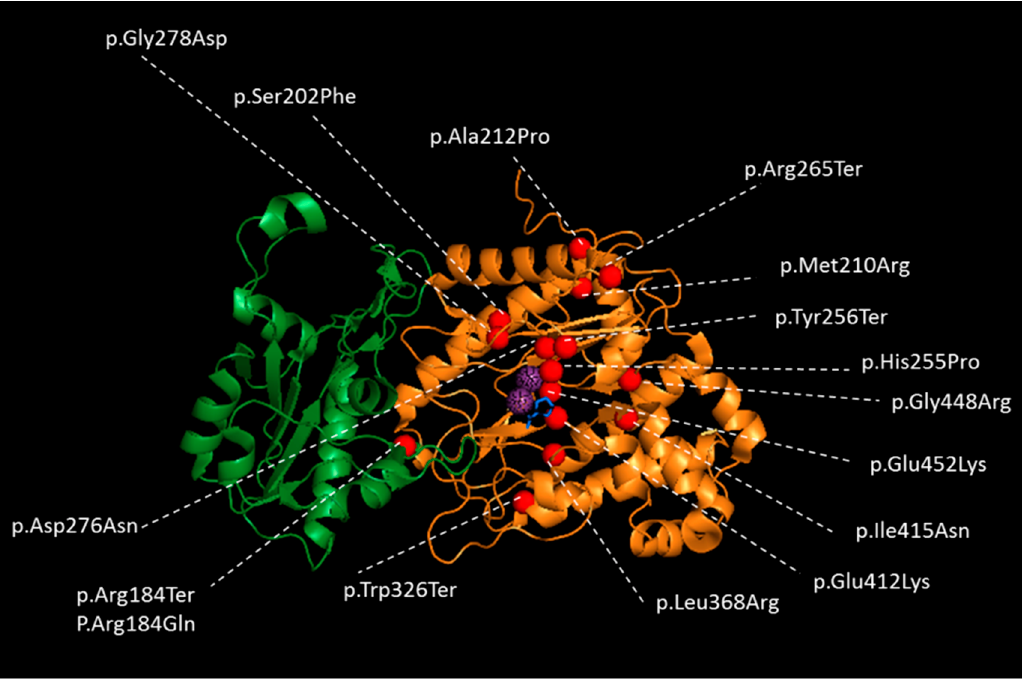
Figure 2. Crystal Structure of one subunit of wild-type Human prolidase dimer as a ribbon representation with reported missense and nonsense variants in patients with PD. The N-terminal domain is colored in green, and the catalytic C-terminal domain in orange. Mn 2+ ions are represented in dotted, violet spheres and Pro ligand with blue sticks to indicate the location of the active sites of the prolidase dimer. Variants are represented as red spheres. The figure performed using PYMOL (the PyMOL Molecular Graphics System, Version 1.7, Schrodinger, LLC, New York, NY, USA) and human protein database (5M4Q) [70].